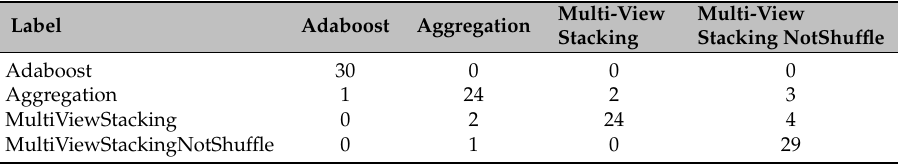
Table 7. Confusion matrix of Multi-view stacking with RFC on a Fingerprint Dataset. Label